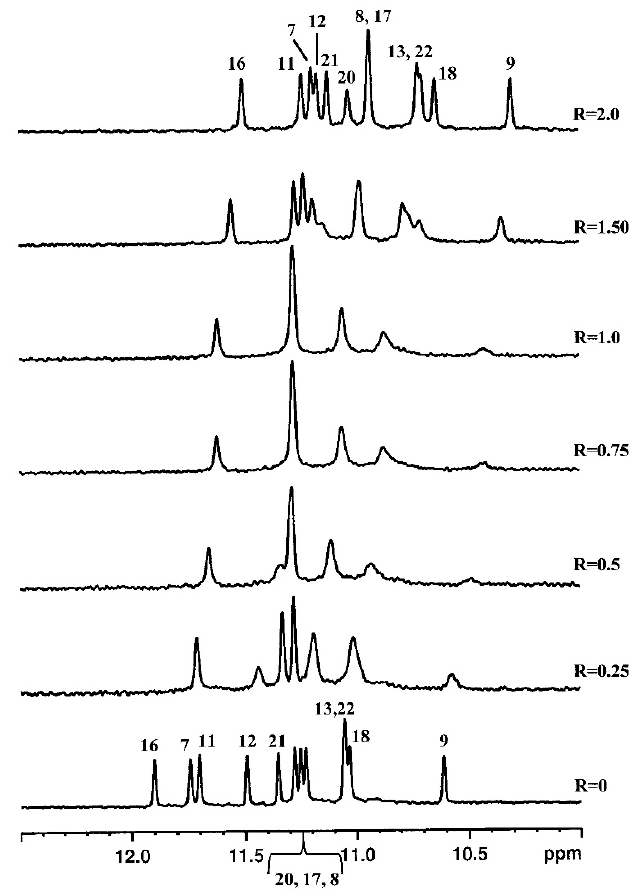
Figure 5. Imino proton region of the 1D NMR titration spectra of Pu22T14T23 with curaxin at 25 °C